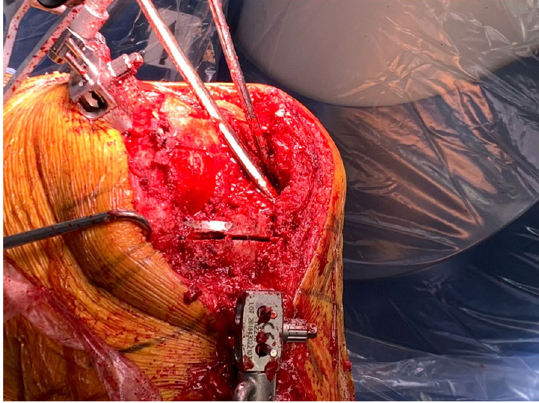
Fig. 12 Placement of array pins in knee incision. Existing tibial tray was removed by using the Mako saw to cut distal to